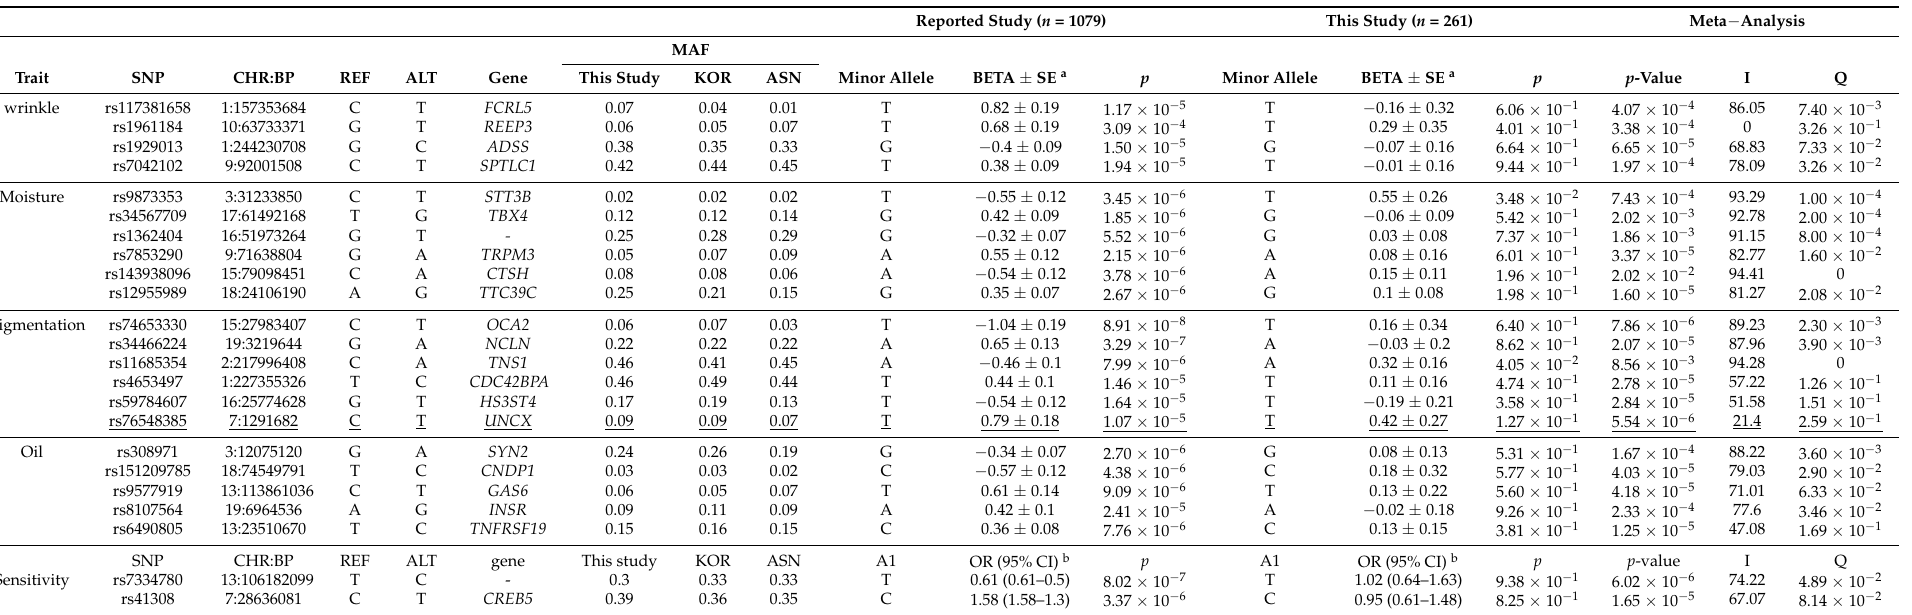
Table 3. Summary of significant skin phenotype loci according to previous